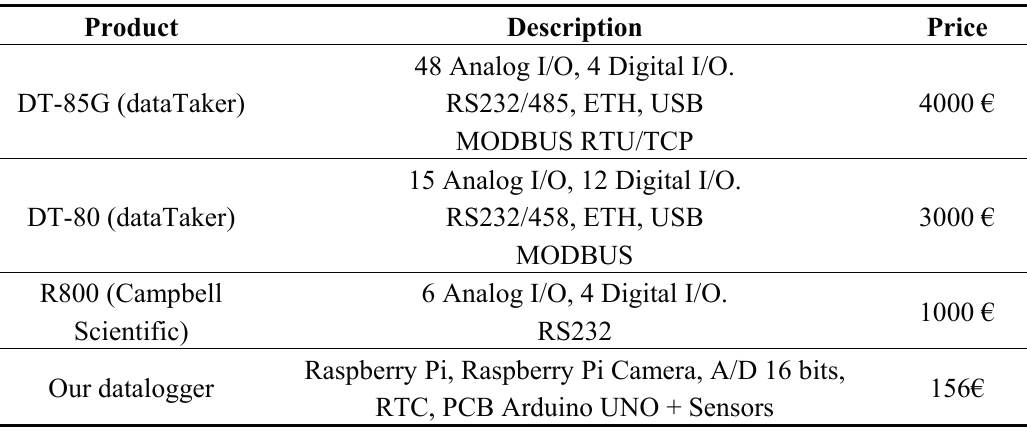
Table 16. Commercial dataloggers and designed datalogger.